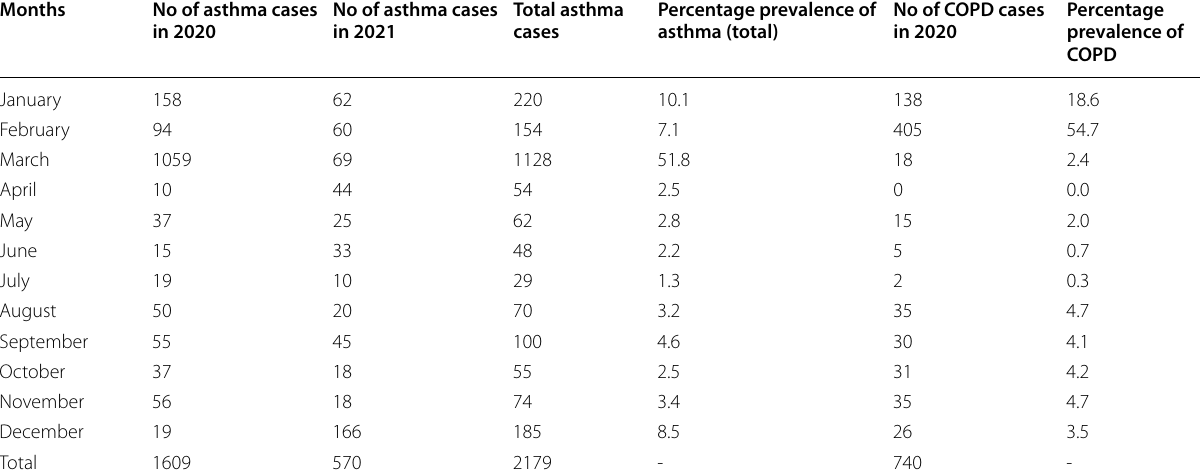
Table 1 Monthly prevalence of asthma (2020 and 2021) and chronic obstructive pulmonary disease (COPD) in 2020 in the District Dera Ismail Khan